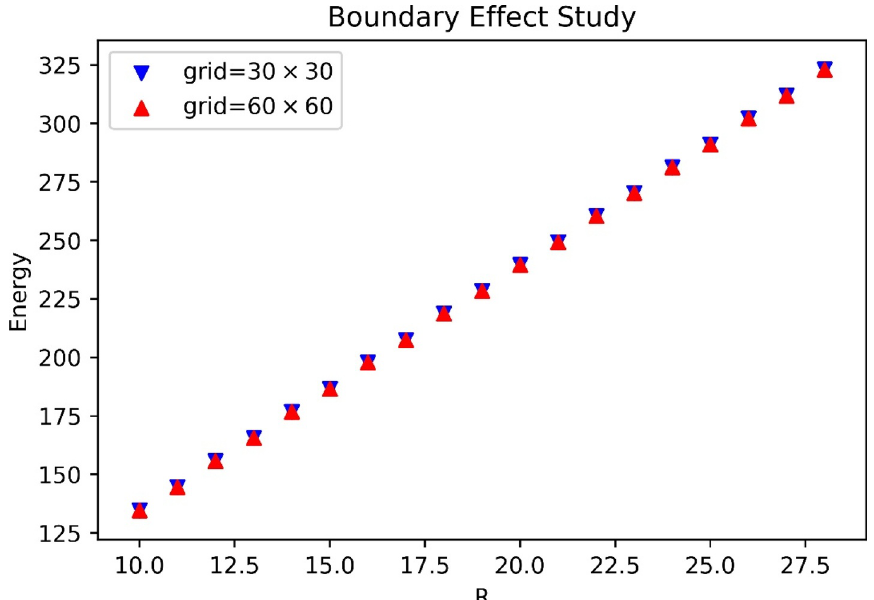
Figure 23. The energy dependence on quark separation R in SU(3) and N-ality k = 1 is tested separately in a 30 by 30 grid and a 60 by 60 grid. The fact that they agree even when the quarks are right at the edge of the smaller grid ( R = 28 ) shows that the boundary effect in this confining theory is minimal, and that taking the finite distance boundary to approximate spatial infinity is